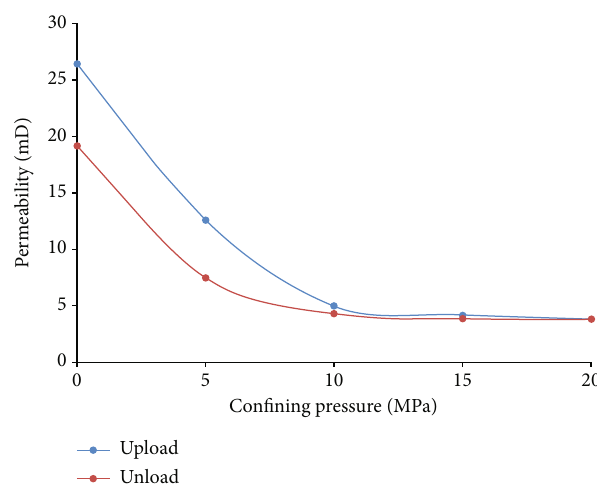
Figure 7: The permeability versus con fi ning pressure for porous